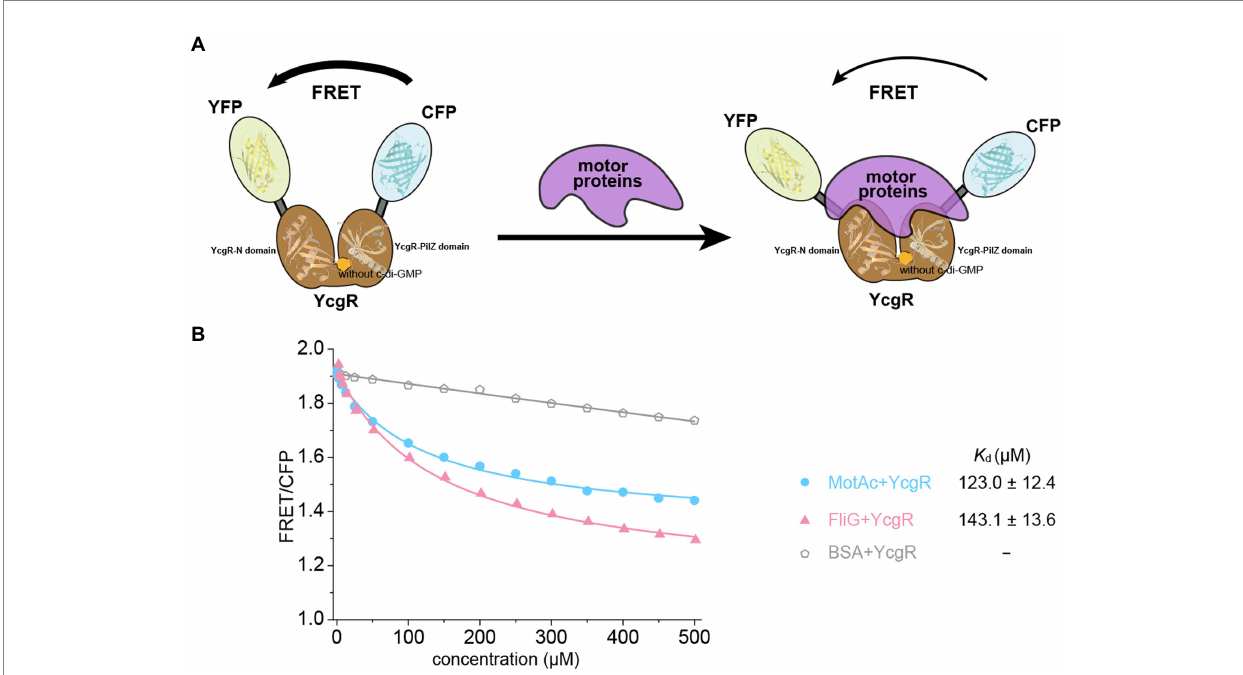
FIGURE 1 YcgR bound to motor proteins in the FRET assay. (A) Scheme illustrating how binding of YcgR to motor proteins leads to a detectable change in FRET between attached yellow (YEP) and cyan (CEP) fluorescent protein domains. The fluorescent subunits were nearby without motor proteins, and FRET was maximal. Motor protein binding to YcgR induced a conformational change that separated the fluorescent domains, decreasing FRET efficiency. (B) Profile of the FRET/CFP emission fluorescence ratio along the increasing concentration of motor proteins (blue line for MotAc and red for FliG). The K d ( μ M) between YcgR and motor proteins were calculated accordingly and shown as mean ± SE. The experiments were repeated three times, and representative examples were